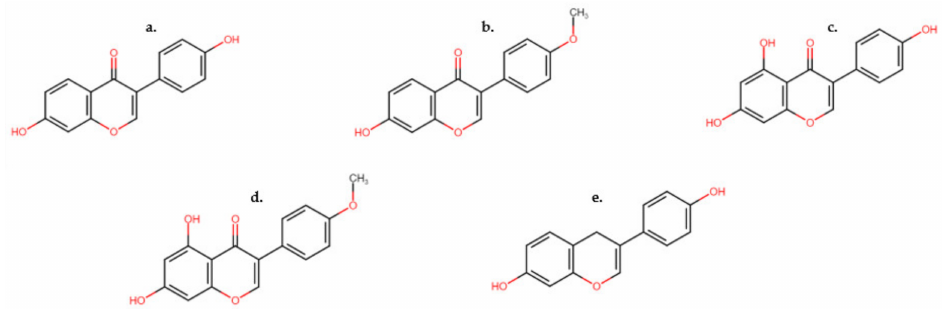
Figure 1. Structures of common isoflavones found in legume species. ( a ) Daidzein, ( b ) formononetin, ( c ) genistein, ( d ) biochanin A and ( e ) equol, a metabolite of